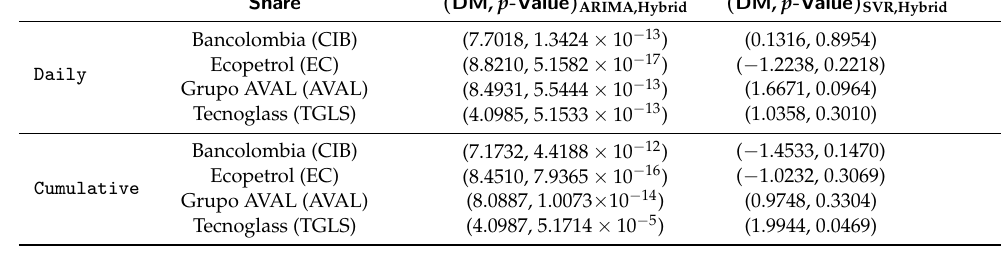
Table 9. The Diebold–Mariano test was used for each prediction pair ( DM , p -value ) SVR,Hybrid , ( DM , p -value ) ARIMA,Hybrid corresponding to the daily or cumulative returns, respectively. Share ( DM , p -Value ) ARIMA,Hybrid ( DM , p -Value ) SVR,Hybrid